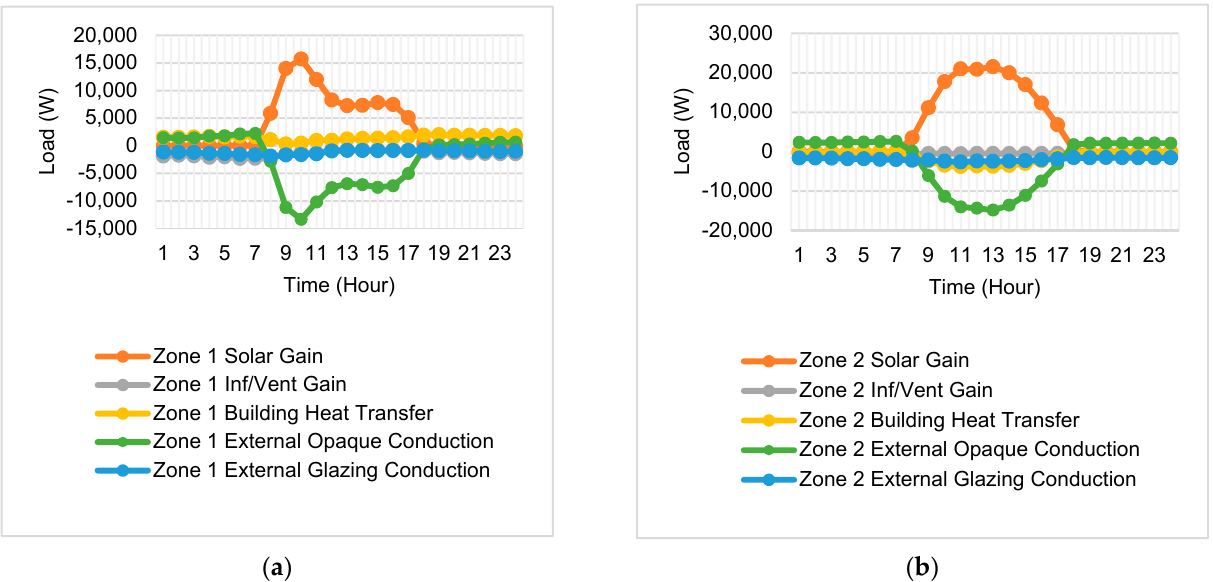
Figure 11. ( a ) Loads breakdown in Hudhayfah mosque (Zone 1) during day 20 (winter); ( b ) loads breakdown in Hudhayfah mosque (Zone 2) during day 20 (winter).